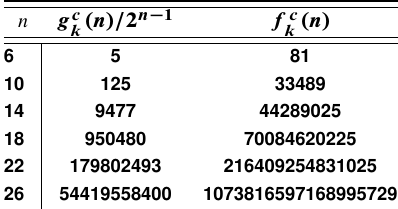
Table 2. Values of g c k .n/ and f c k .n/ up to n D 26